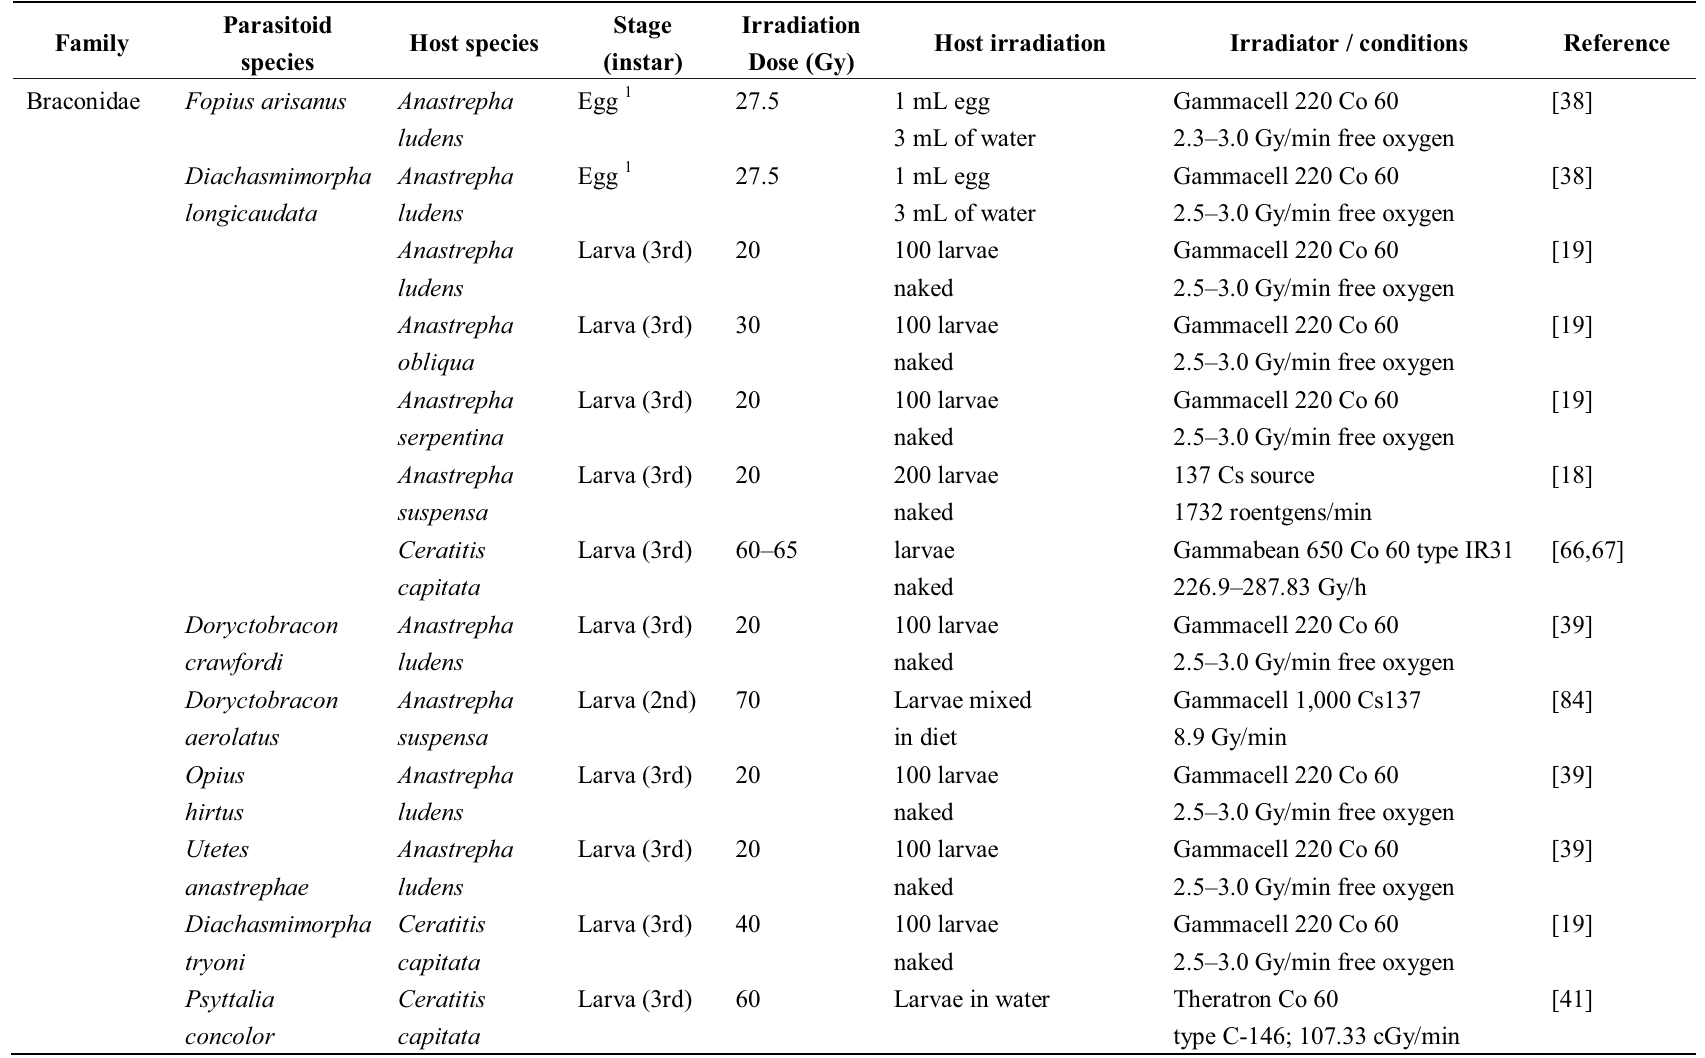
Table 1. Host stages, instars and radiation dosages used in the mass-rearing of various egg, larval and pupal hymenopteran parasitoids of tephritids under different host and irradiator